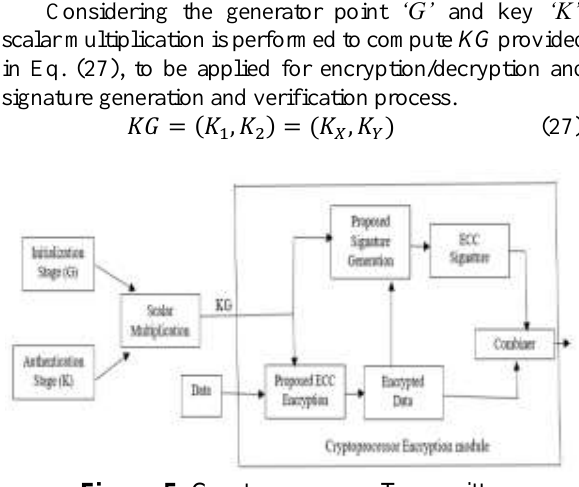
Figure 5. Cryptoprocessor